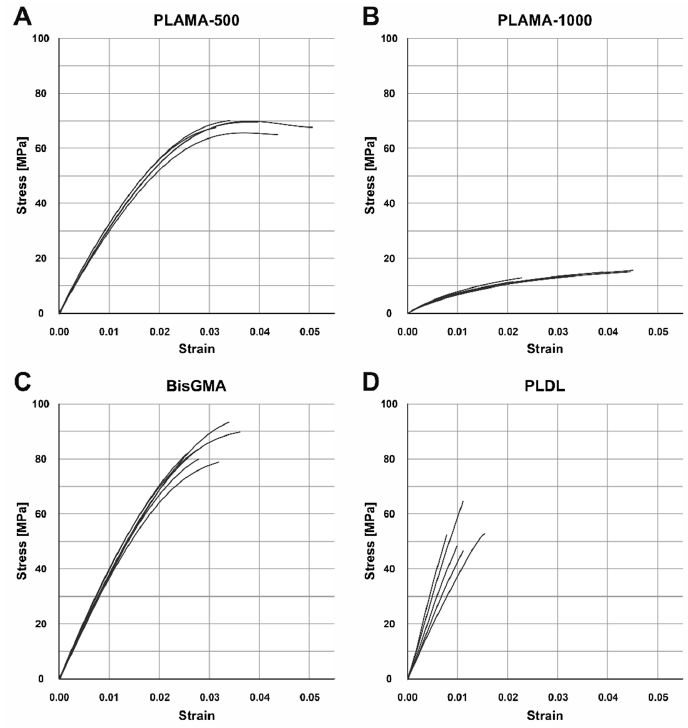
Figure 5. Engineering stress-strain curves of the tensile test in groups: PLAMA-500 ( A ), PLAMA-